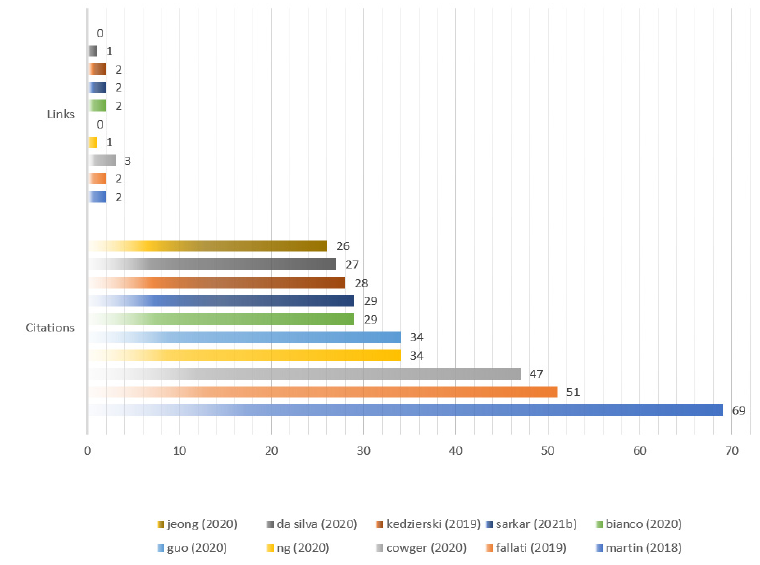
Figure 20. The most cited references.